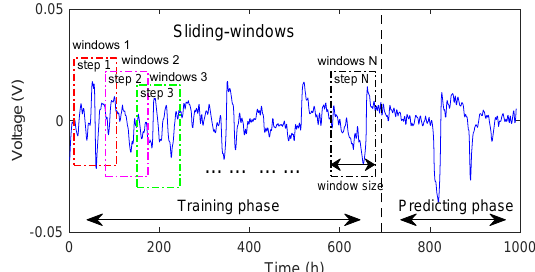
Figure 5. Sliding-window strategy during LSTM